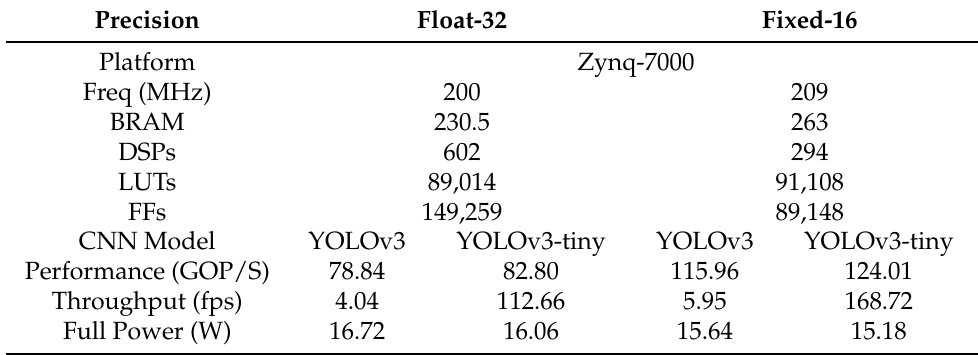
Table 9. Performance and power consumption of the